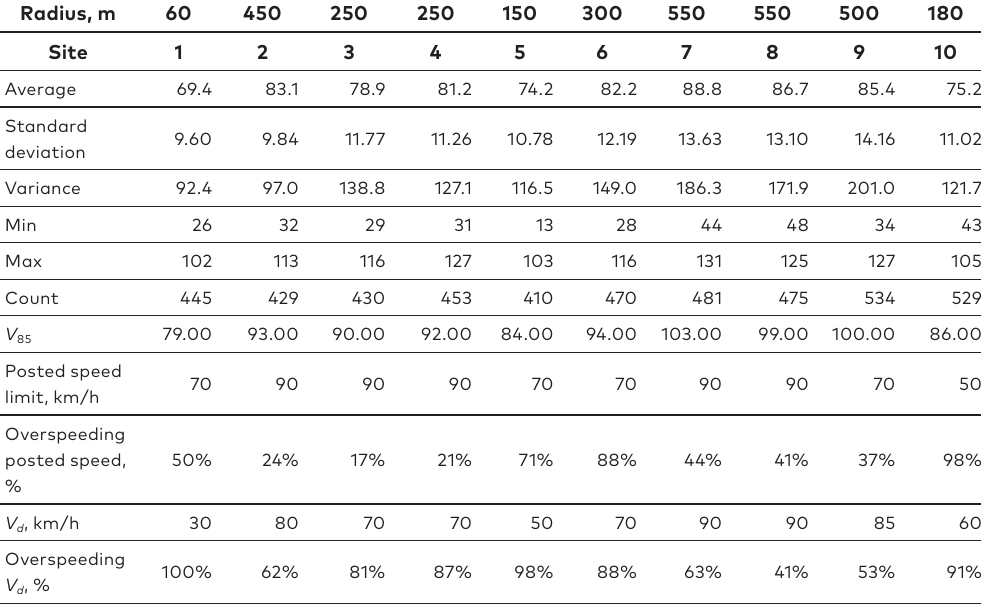
Table 5. Descriptive results for unisolated vehicles in all Sites